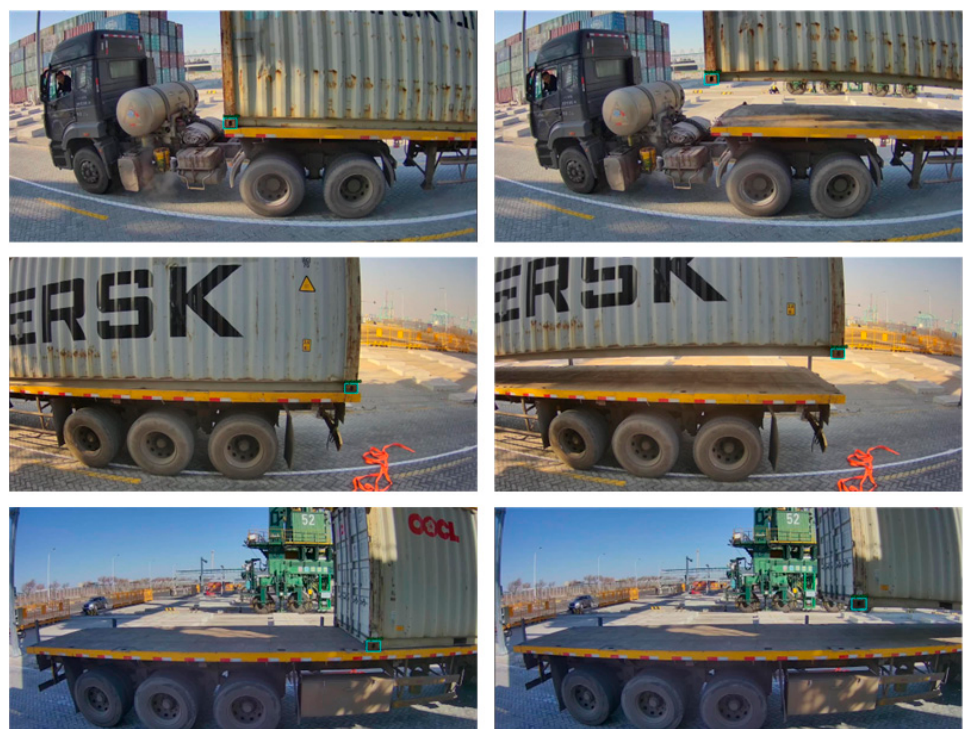
Figure 17. Tracking results.